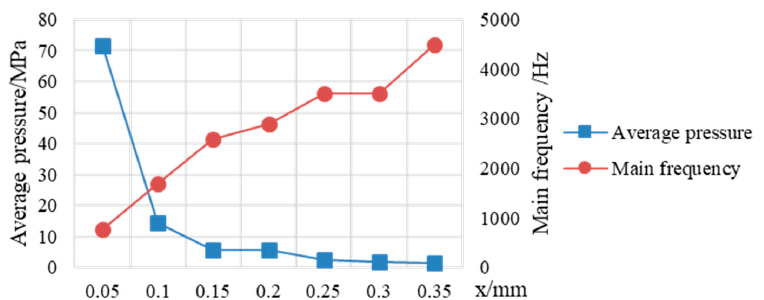
Figure 16. Average pressure and main frequency of the flapper at different actual distances between the nozzle and flapper.